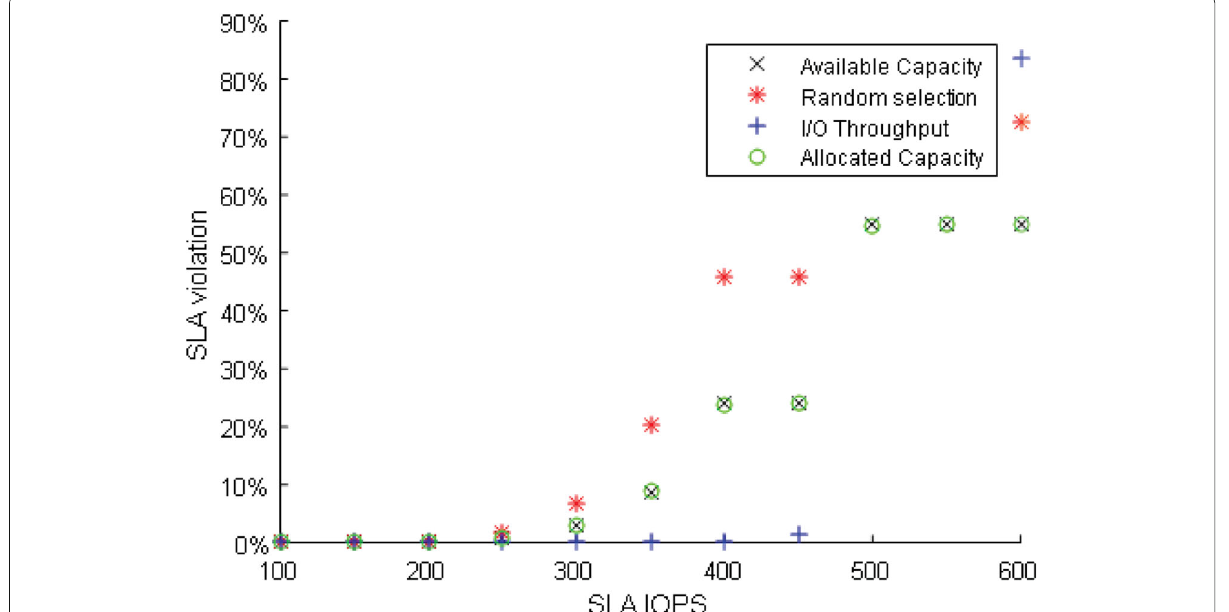
Fig. 5 Different SLA violation rates of different weight strategies with different